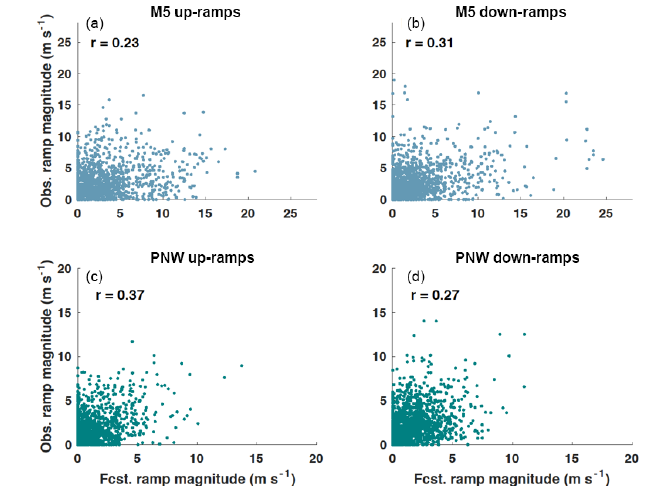
Figure 8. Observed (obs) and HRRR-forecasted (fcst) wind speed ramps during sliding 3h time windows over a period of 12h. Abso- lute values of the ramp magnitudes are shown. Wind speed ramps are plotted for every sliding 3h time window starting at 00:00UTC and for both the M5 (a, b) and PNW (c, d) tower locations. The cor- relation coefficient, r is displayed for each tower location and type of